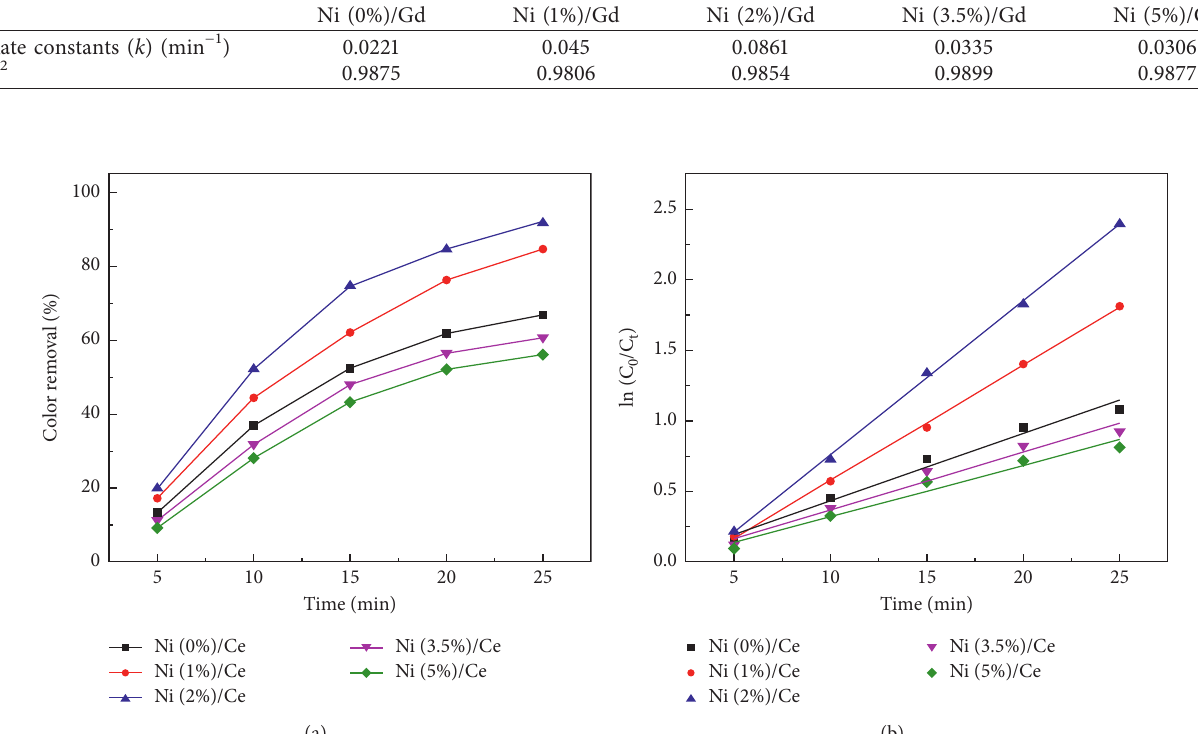
2 -Sb-Ni/Gd electrodes modified with various Ni